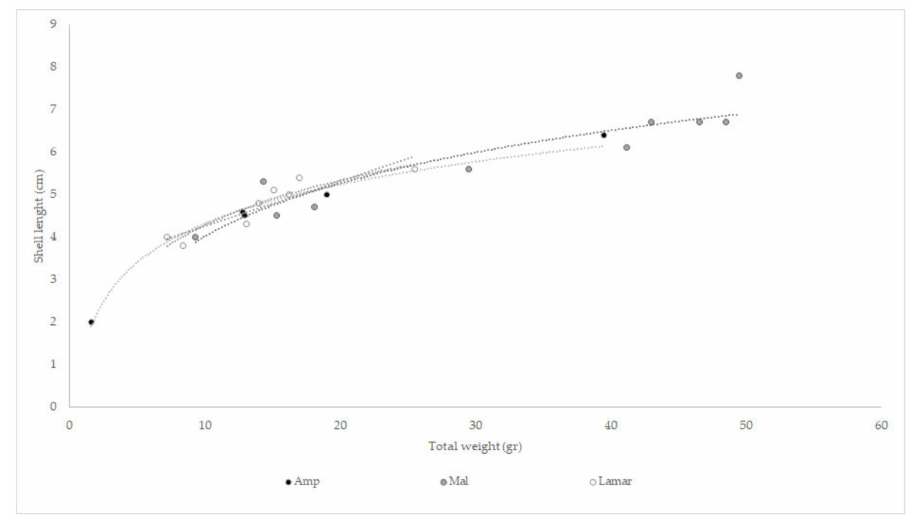
Figure A2. Shell length (cm) and body weight (g) measurements of pearl oyster ( Pinctada imbricata radiata ) at 3 IMTA farms (Aq1: Epidauros, Aq2: Evoikos, Aq3: Rhodos). Each dashed line repre- sents the length-weight relationships (W = aln(L) + b) for pearl oysters under IMTA conditions in Aq1 Aq2 and